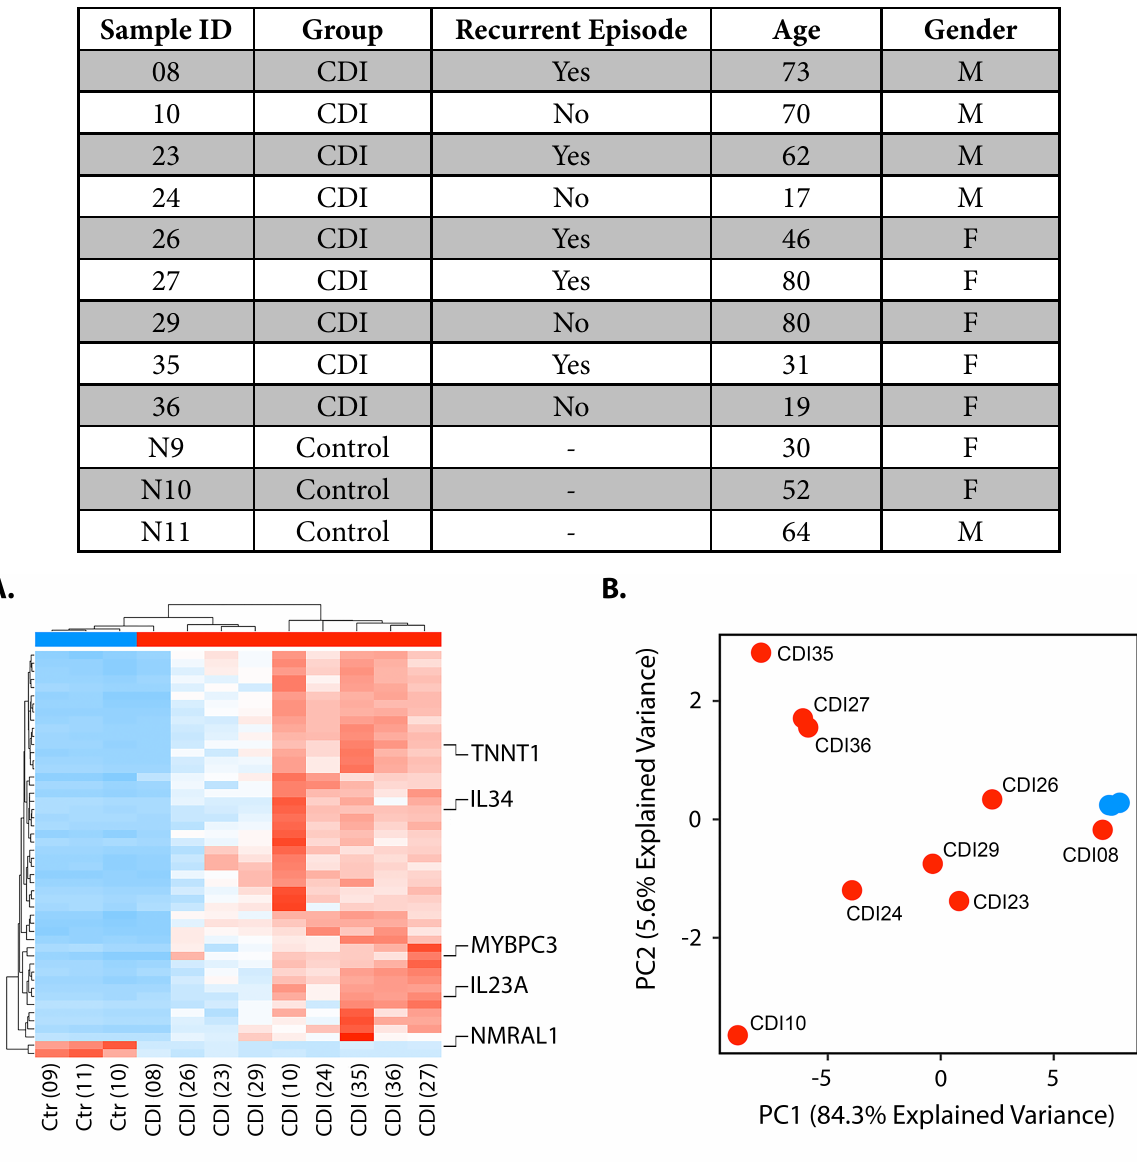
Figure 2 . mRNA expression in patients with CDI vs controls. A) Relative expression levels of the top 50 of these differentially expressed genes between patients with CDI and diarrhea of other causes. B) Princi- pal component analysis demonstrated 84.3% of the variance explained by principal component (PC)